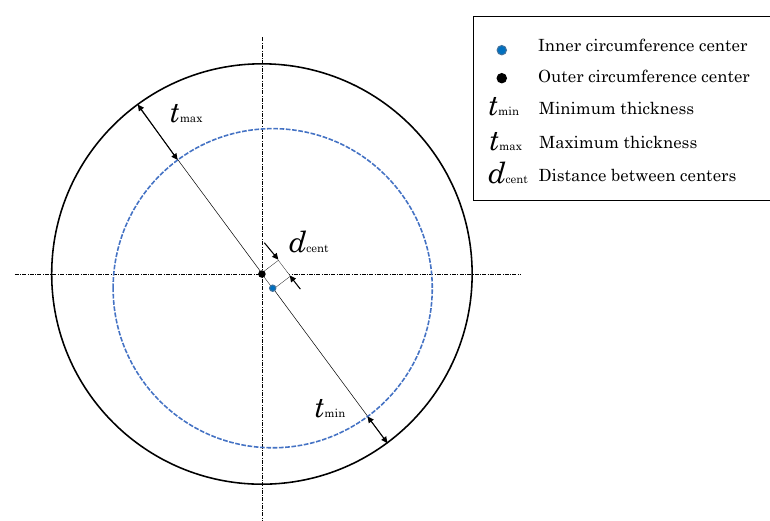
Figure 3. Representation of the wall thickness eccentricity imperfection in a section of a tube.